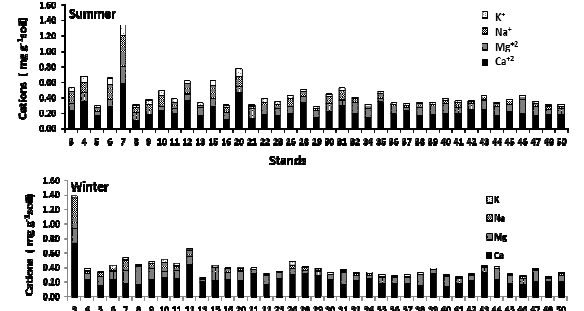
Fig. 2. Concentration of major soluble cations (Na + , K + , Ca +2 , Mg +2 ), expressed in mg g -1 soil of the different studied stands inhabited by studied plants in Wadi El-Assiuty in winter and summer seasons